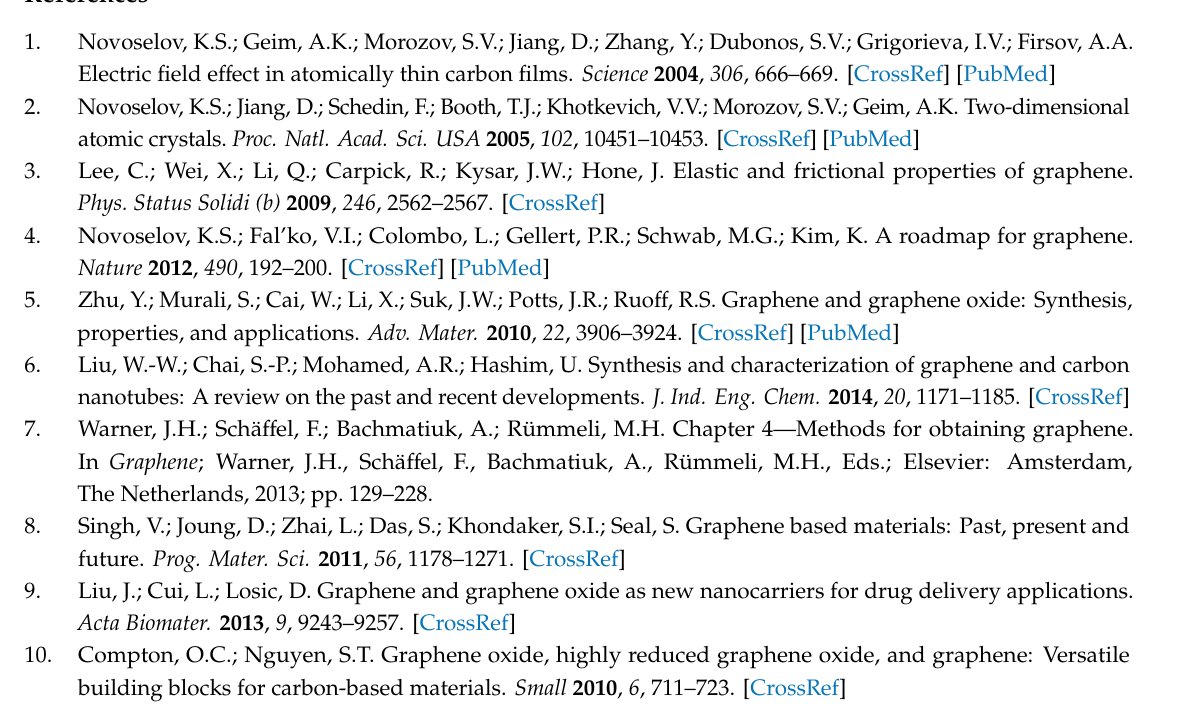
Table S1: Elemental compositions investigated by XPS, Table S2: Wide-scan spectrum of the sample recorded from the graphene stacks, Table S3: C 1s spectrum of the sample recorded from the graphene stacks, Table S4: Wide-scan spectrum of the GO sample, Table S5: C 1s spectrum of the GO sample, Table S6: N 1s spectrum of the GO sample, Table S7: Wide-scan spectrum of the PDA-GO_30 sample, Table S8: C 1s spectrum of the PDA-GO_30 sample, Table S9: N 1s spectrum of the PDA-GO_30 sample, Table S10: Wide-scan spectrum of the RGO_30 sample, Table S11: C 1s spectrum of the RGO_30 sample, Table S12: N 1s spectrum of the RGO_30 sample, Table S13: Wide-scan spectrum of the PDA-GO_90 sample, Table S14: C 1s spectrum of the PDA-GO_90 sample, Table S15: N 1s spectrum of the PDA-GO_90 sample, Table S16: Wide-scan spectrum of the PDA-GO_180 sample, Table S17: